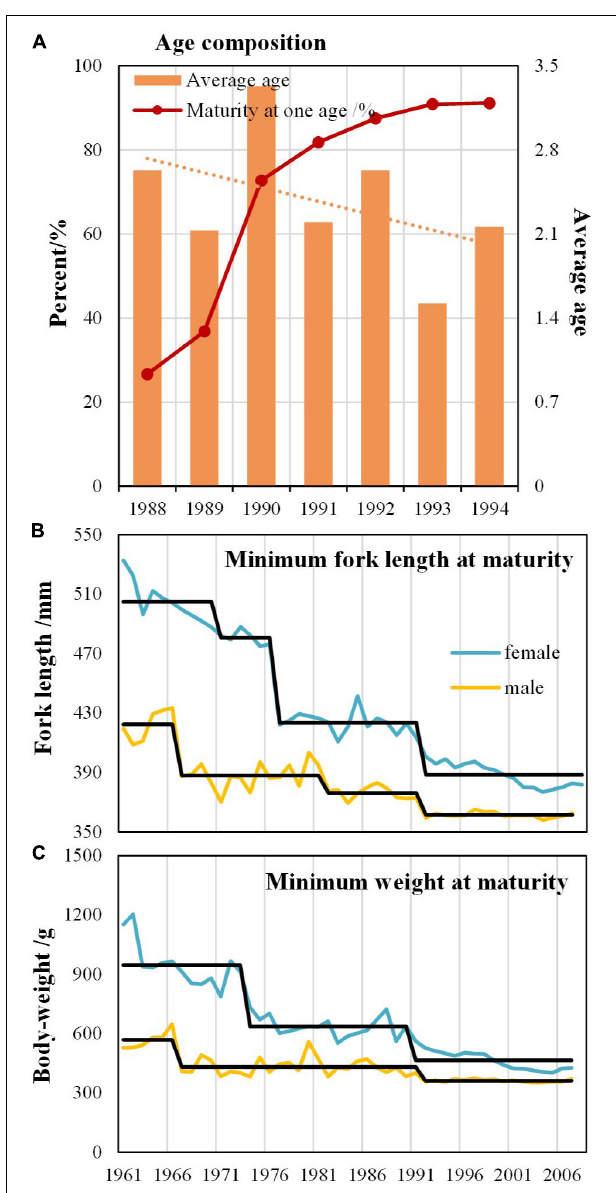
FIGURE 6 | Changes in life history traits of Japanese-Spanish mackerel ( Scomberomorus niphonius ) from the Bohai Sea and the Yellow Sea: (A) variations in age composition; (B,C) variations in body-size with step